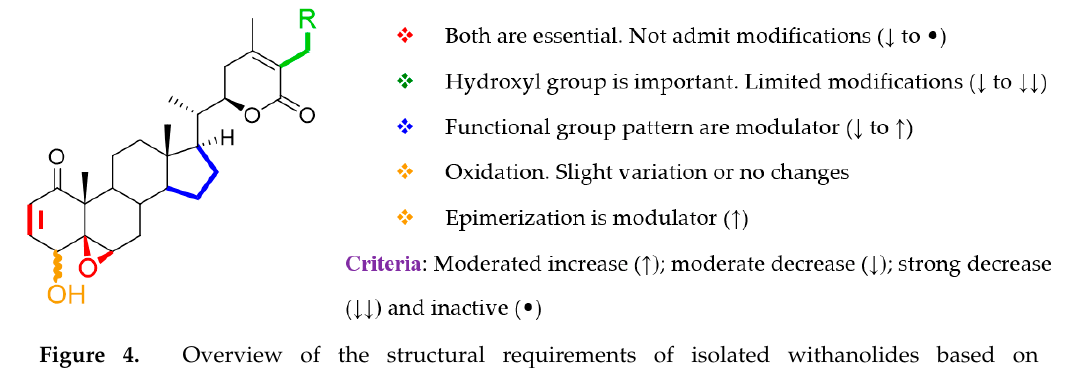
Figure 4. Overview of the structural requirements of isolated withanolides based on structure–anti- leukemic activity relationship